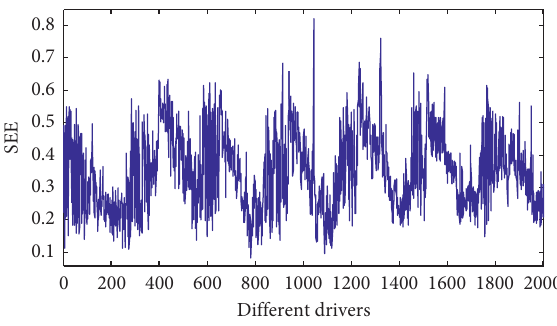
Figure 11: Simulation of SEE.